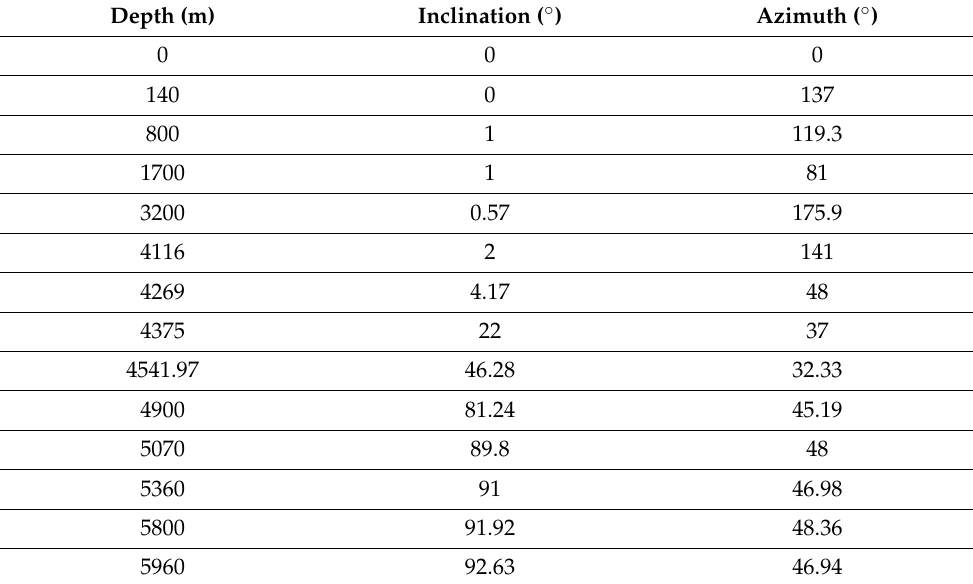
Table 7. Well trajectory data for well N.